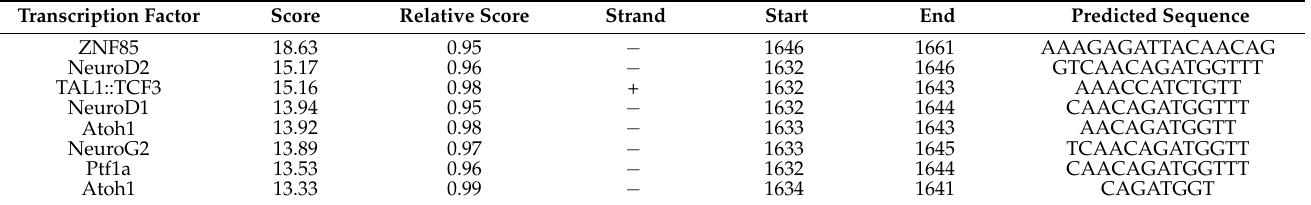
Table 5. Association analysis between genotype frequency of SNP and food preference in mandarin